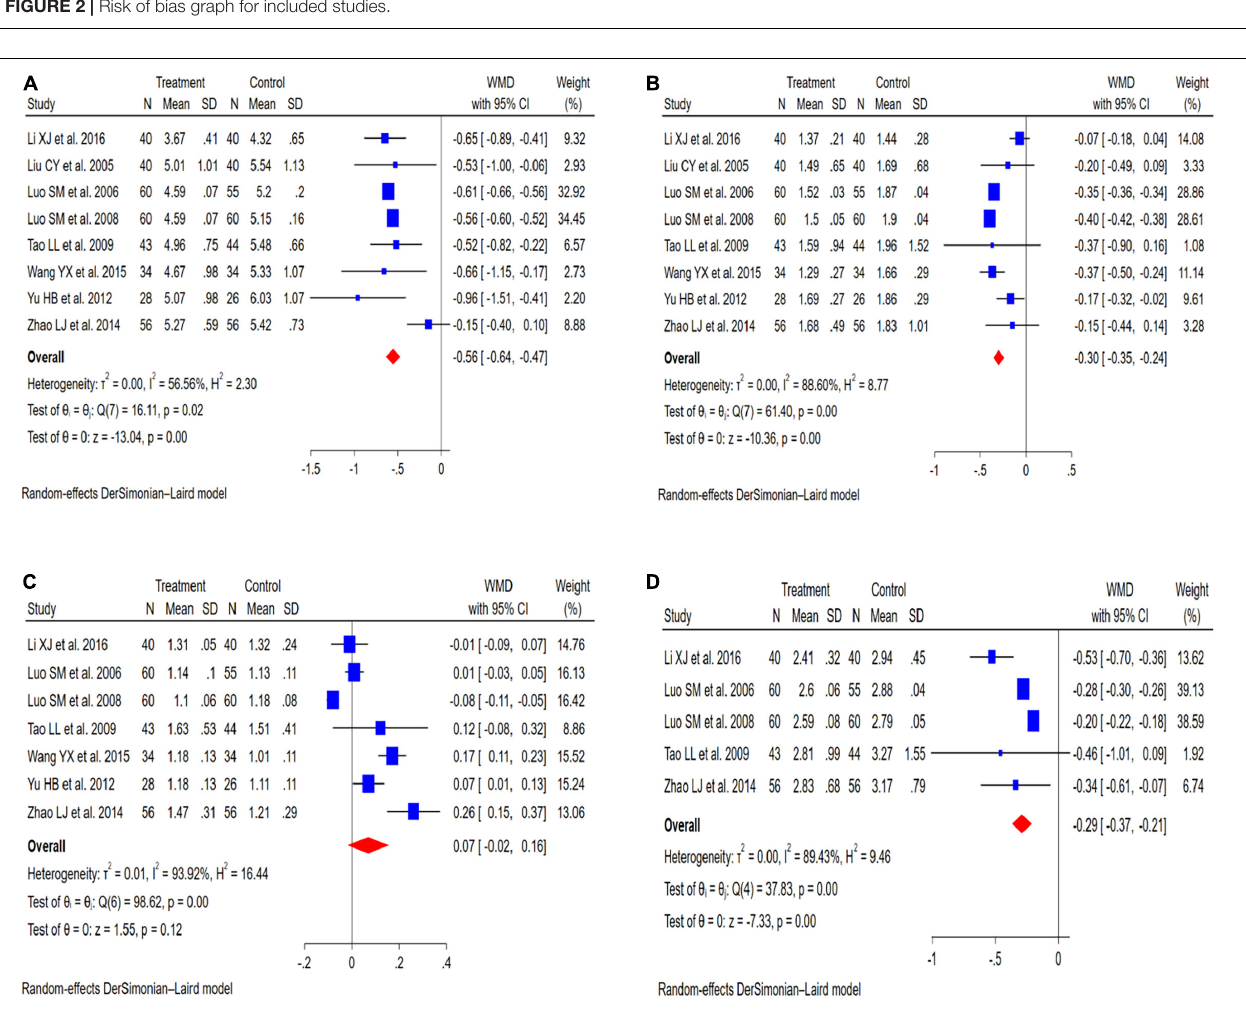
FIGURE 3 | Meta-analysis results of KT supplementation for lipid levels. (A) TC levels. (B) TG levels. (C) HDL-C levels. (D) LDL-C levels.